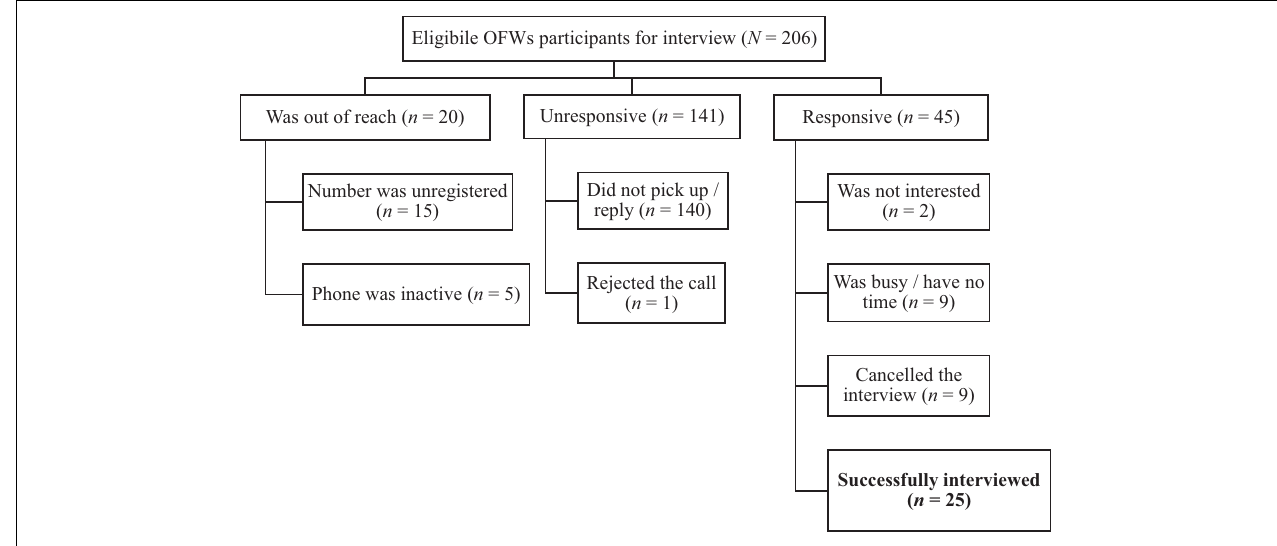
FIGURE 2 | Participants recruitment for interviews from both completer and non-completer